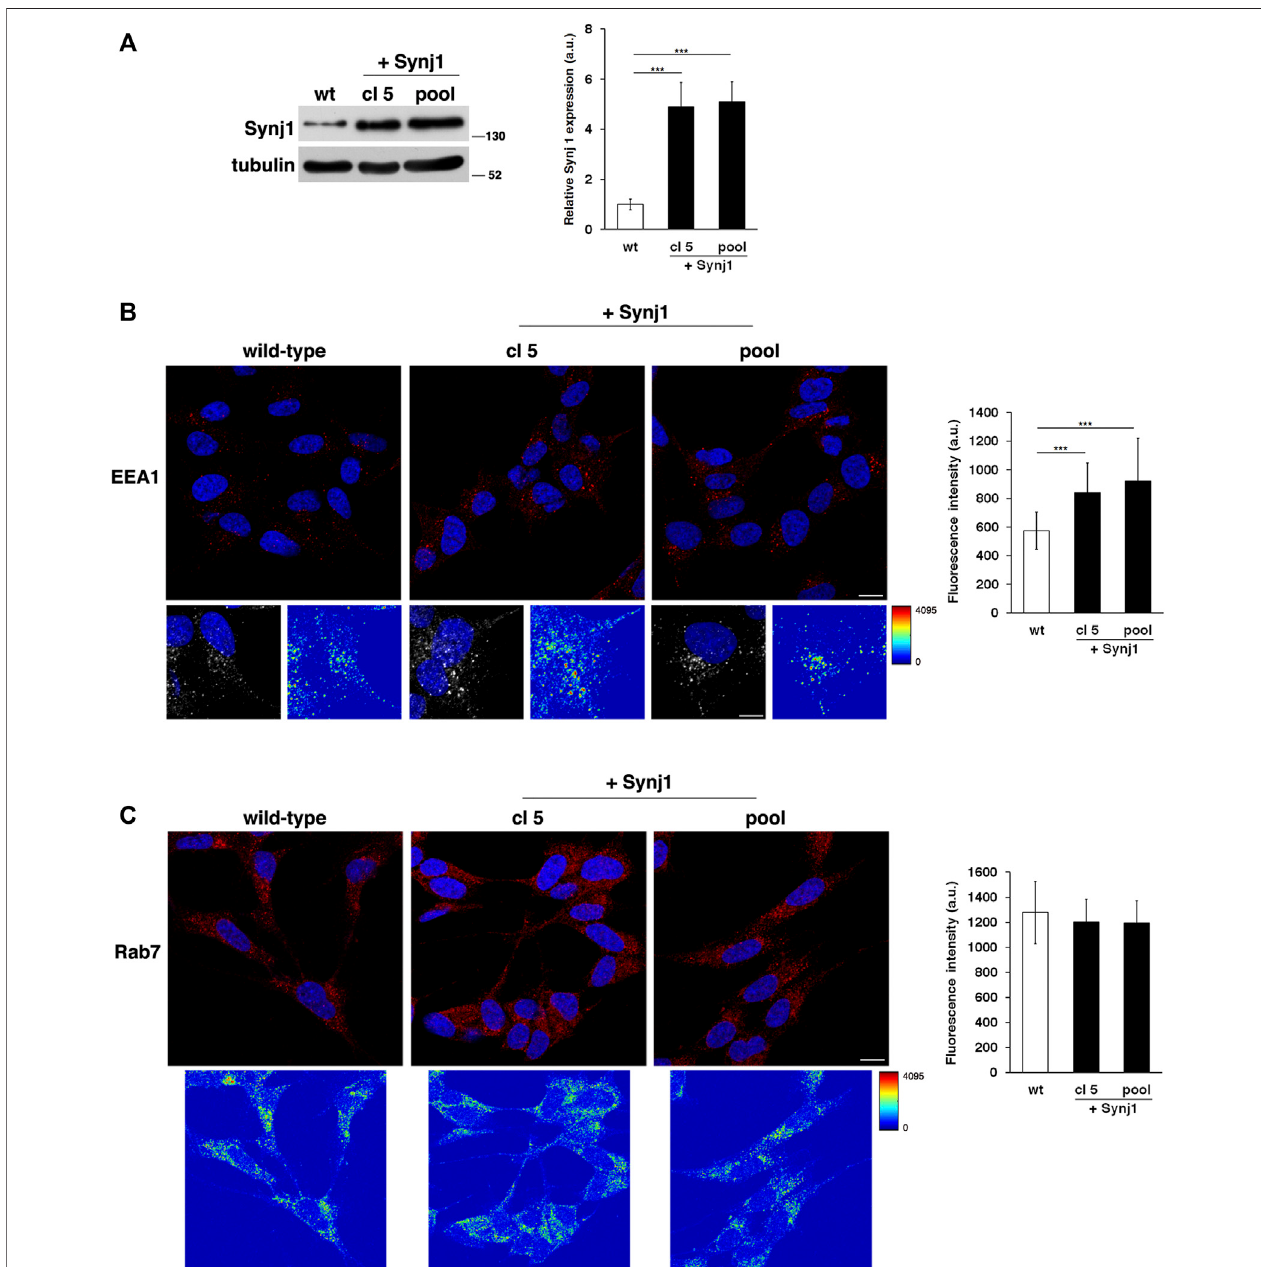
FIGURE6| Synj1overexpressionaffectsthe homeostasis ofearlyendosomes,but notoflateendosomes,inSH-SY5Y cells. (A) SH-SY5Ycells stablytransfected withcDNAencodingforwild-typeSynj1weretestedfortheexpressionofSynj1byWesternblotting.RepresentativeimmunoblottingofSynj1inasingleclone(cl5)andin a pool of clones (pool) is shown. Tubulin was used as the loading control. The molecular weight of protein markers is indicated. Densitometric analysis of three different experiments is shown. Error bars, mean ± SD. (B) Cells were stained with EEA1 antibody detected with Alexa-546-conjugated secondary antibodies. Serial confocalsectionswerecollectedfromthetoptothebottomofthecells;scalebars,8 μ m.Foreachcondition,the3Dreconstructionandcorrespondingintensitymapare shown; scale bars, 5 μ m. The mean fl uorescence intensity (arbitrary unit, a.u.) of EEA1-positive structures is higher in Synj1-overexpressing than in wild-type cells. The bars show the relative mean value ± SD of three independent experiments, n ≥ 50 cells. (C) Immunostaining of Rab7 in wild-type and Synj1-overexpressing cells is shown. For each condition, the corresponding intensity map is shown. Scale bars, 8 μ m. Mean fl uorescence intensity (arbitrary unit, a.u.) is shown. The bars show the relative mean value ± SD of three independent experiments, n ≥ 50 cells. *** p < 0.001, Student ’ s t -test.